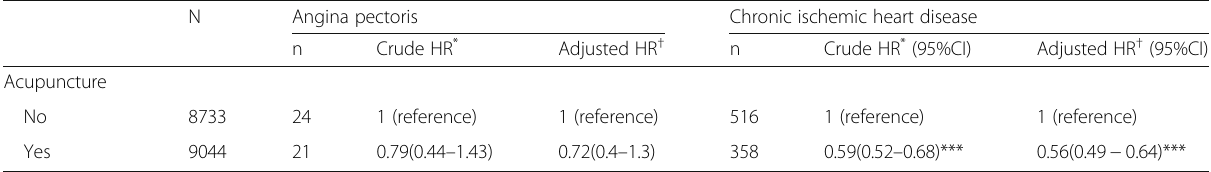
Table 5 Cox model for angina pectoris and chronic ischemic heart disease in patients with rheumatoid arthritis receiving acupuncture treatment vs. not receiving acupuncture treatment